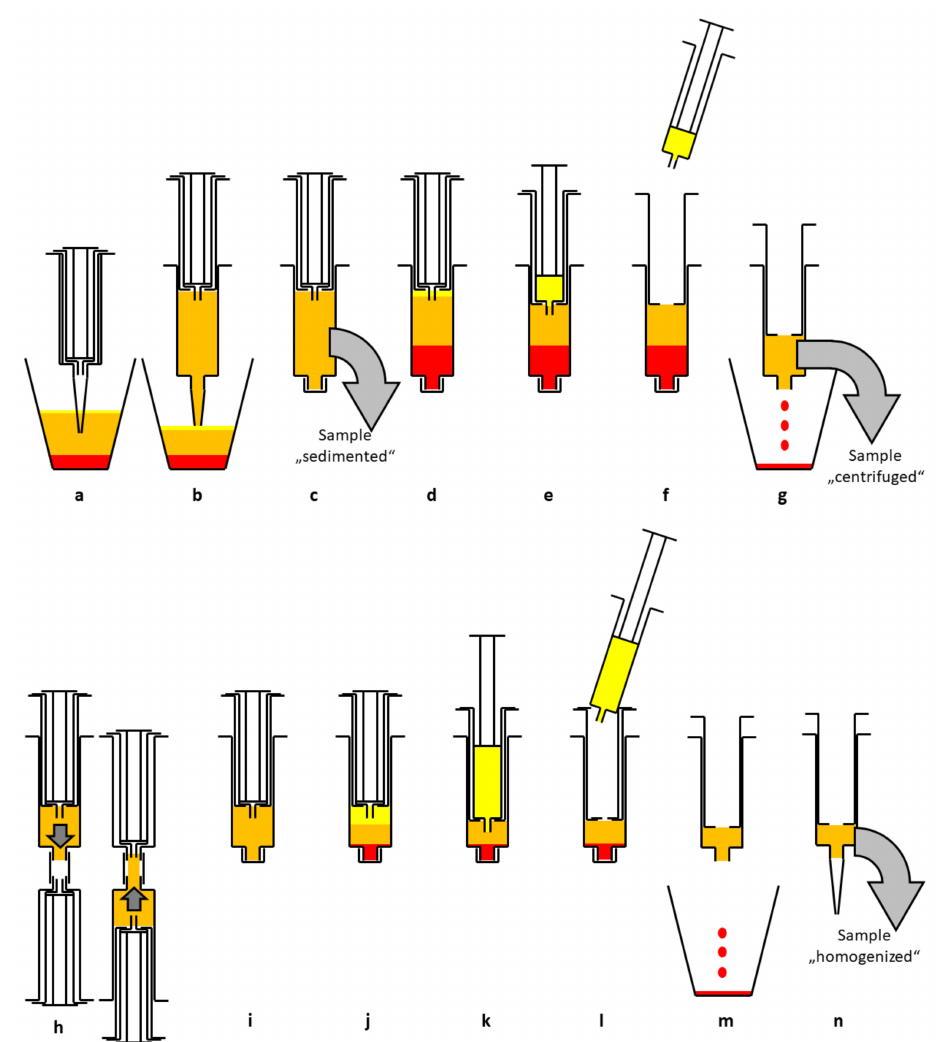
Figure 1. Schematic diagram of the enrichment process. After sedimentation in the suction container ( a ) lipoaspirate is transferred to a 15 mL double syringe ( b ). The sample “sedimented” is taken for analysis ( c ). After centrifugation (2500 rpm, 4 min) three layers can be seen ( d ). The upper oil phase is transferred to the small inner syringe ( e ) and discarded ( f ). The blood and tumescent solution are discarded as well ( g ). The sample “centrifuged” is taken for analysis. The syringe is connected to a Tulip-1.4-mm connector and another syringe and the lipoaspirate is emulsified by forcing it through the connector at least 10 times ( h ). The now homogenized lipoaspirate ( i ) is centrifuged again at 2500 rpm for 4 min, resulting in three layers ( j ). The upper oil phase from disrupted adipocytes is transferred to the small inner syringe ( k ) and discarded ( l ). The aqueous phase is discarded, too ( m ). The remaining lipoaspirate contains a high percentage of ASCs and is ready for lipofilling ( n ). The sample “homogenized” is taken for